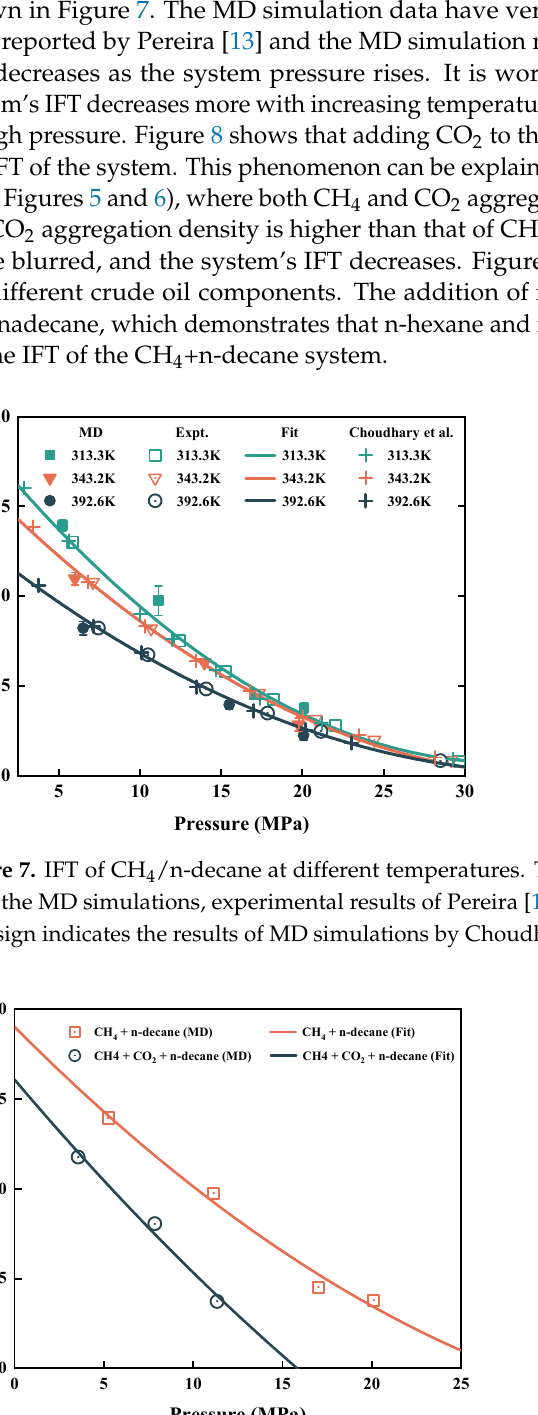
Figure 6. Number density distribution of CH 4 /CO 2 /n-decane at 313.3 K,11.14 MPa. (The # symbol in the unit represents the number of molecules).